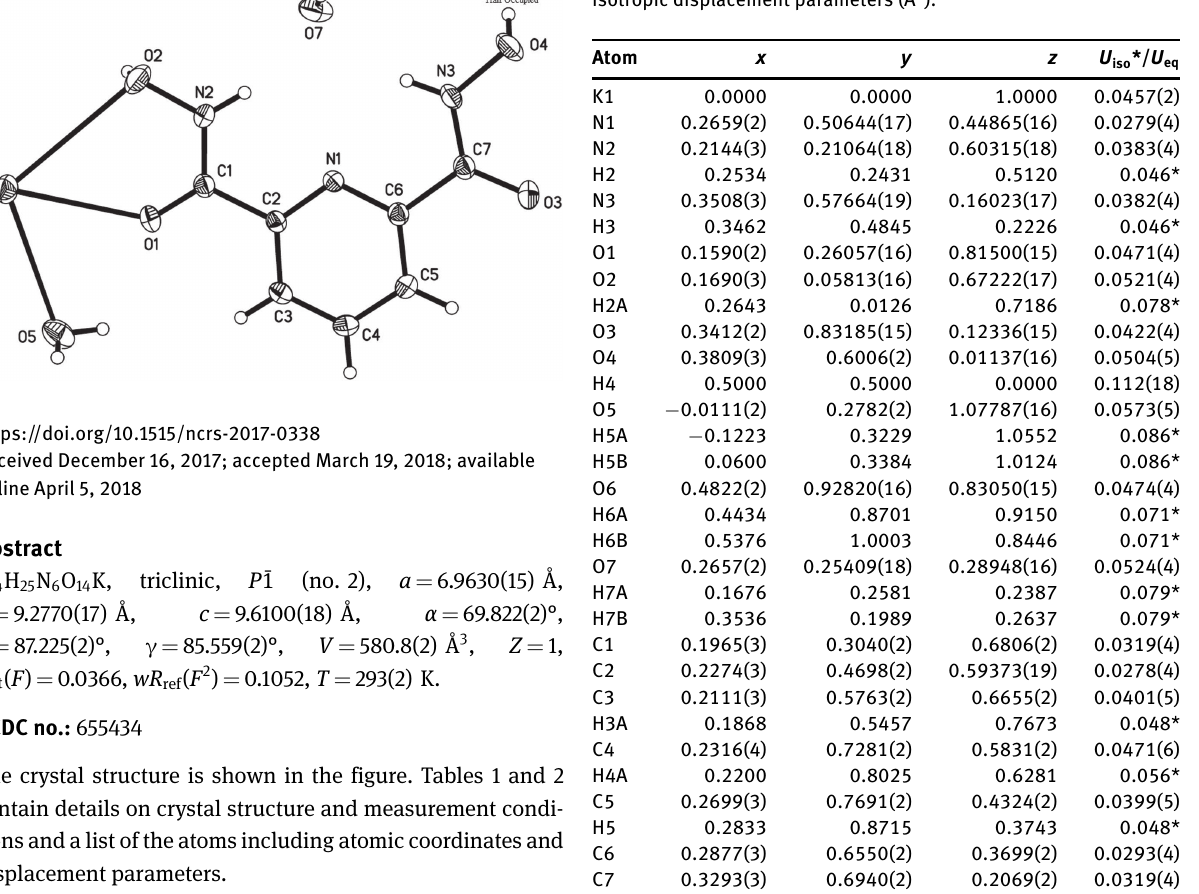
Table 2: Fractional atomic coordinates and isotropic or equivalent isotropic displacement parameters (Å 2